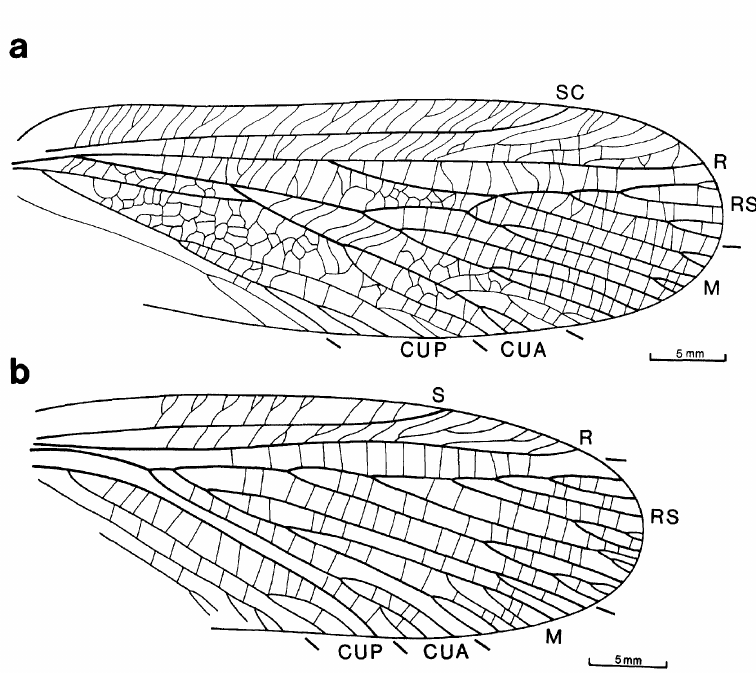
Fig. 14. Gerarus.lischeri, a. drawing of fore wing, based on specimens IP 4, 5, 7, and 23. b. drawing of hind wing based on specimens IP 5, 7, and